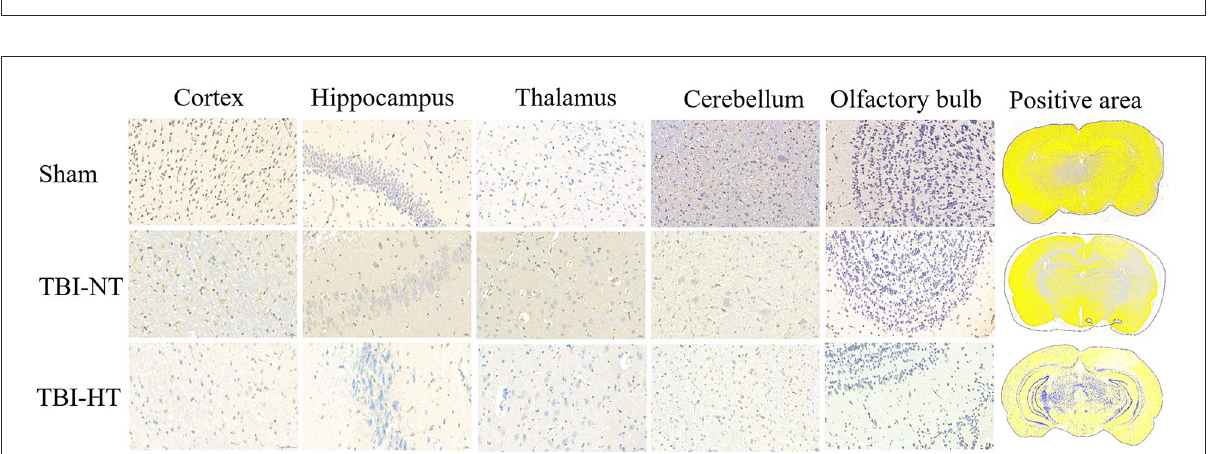
system (10). Thus, normalizing AQP 4 expression in the acute phase of TBI may provide a therapeutic avenue to eliminate edema and improve the clearance of interstitial wastes after